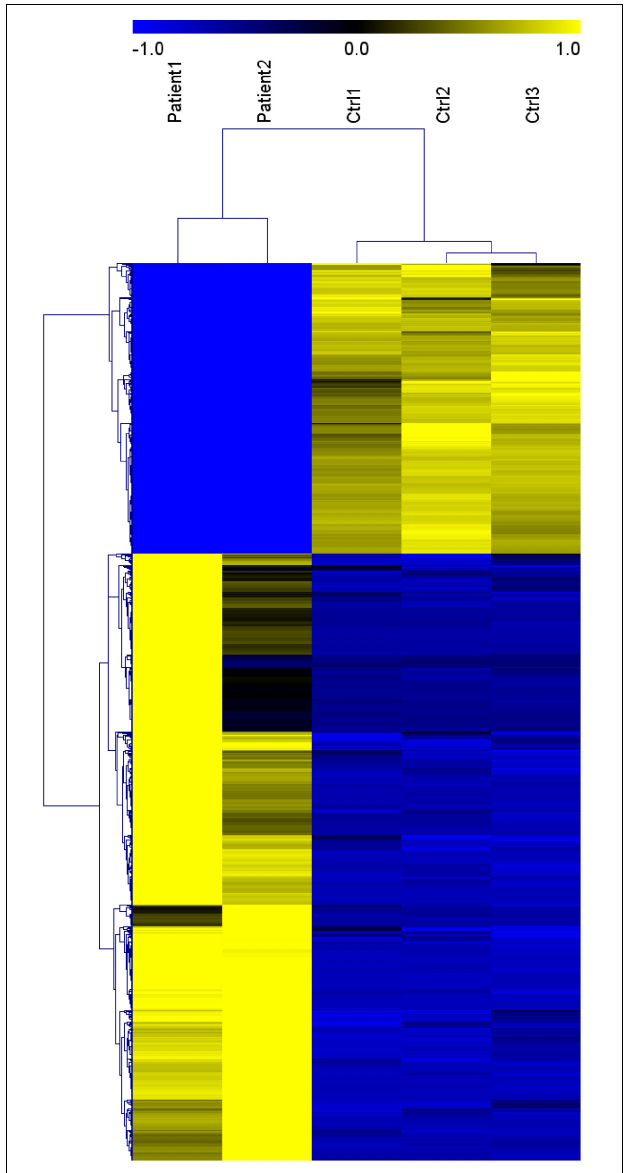
FIGURE 1 | Heat map of genes significantly up-regulated and down-regulated (fold change > 2) in COVID-19 patients BALF. (Patient 1-2 vs. Ctrl 1-3). This figure is tansformed from the materials of Yong X. et al. (Xiong et al., 2020). Published by Informa UK Limited, trading as Taylor & Francis Group, on behalf of Shanghai Shangyixun Cultural Communication Co., Ltd. This is an Open Access article distributed under the terms of the Creative Commons Attribution License (http://creativecommons.org/licenses/by/4.0/), which permits unrestricted use, distribution, and reproduction in any medium, provided the original work is properly